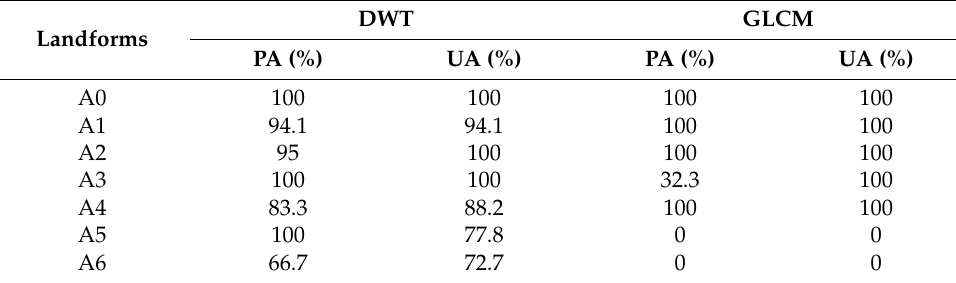
Table 4. The PA and UA of classification of different